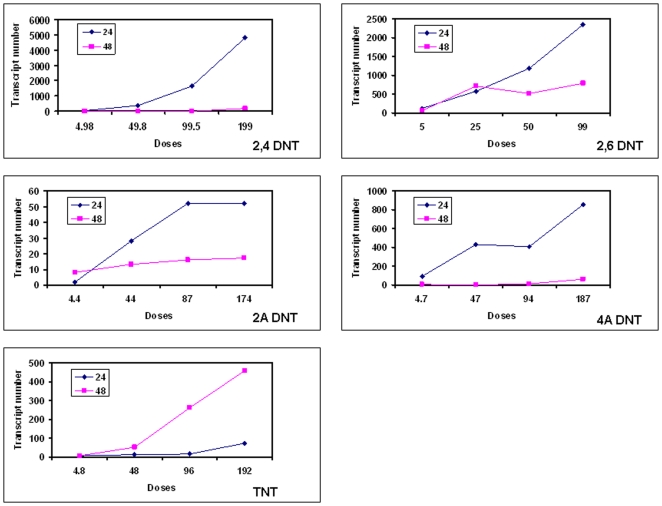
The dose and time dependent numbers of transcripts regulated by 2,4DNT, 2,6DNT, 2ADNT, 4ADNT or TNT.Rats were exposed to one of the 5 compounds for 24 h (blue line) or 48 h (red line), with one of 4 doses plus vehicle controls. Rats were sacrificed and liver tissues were employed for total RNA isolation and microarray hybridization and analysis as described in Materials and Methods. The numbers of transcripts at Y axis were achieved by comparing the gene expression profiles of animals treated with one of four doses with respective control animals at the time point 24 h or 48 h for one of the compounds.